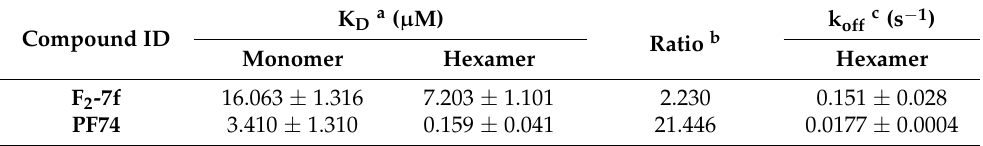
Figure 3. SPR isotherms of F 2 -7f ( A ) binding to two variants (monomer and disulfide-stabilized hexamer) of the CA protein using PF74 ( B ) as the reference. Isotherms are an average of 3 replicates with error bars indicating the standard deviation (SD). Table 3. SPR results of F 2 -7f and PF74 binding to monomeric and hexameric CA